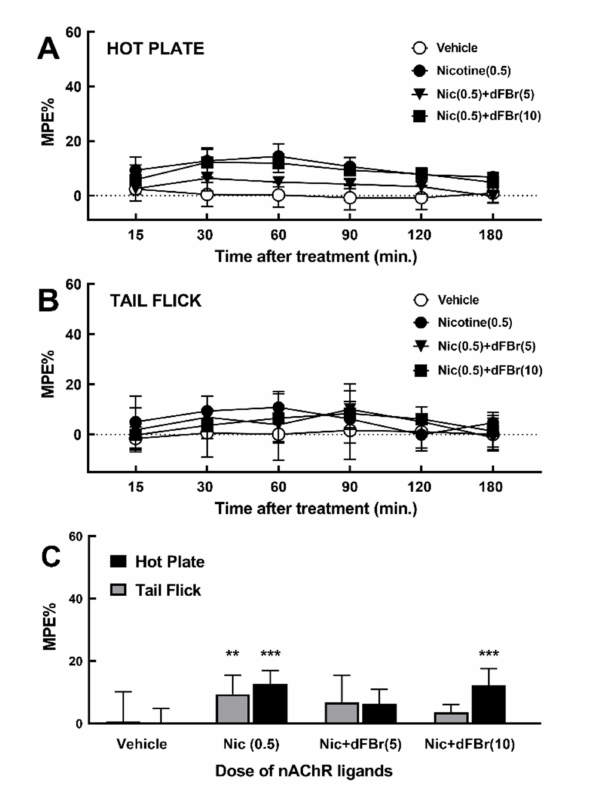
Figure 4. ( A and B ) Time course of the e ff ects of dFBr on nicotine-induced acute thermal antinociception in the hot plate and tail flick tests, respectively. Rats were pretreated with i.p. injection of vehicle or dFBr then with s.c. injection of 0.5 mg / kg nicotine, then subjected to the hot plate or tail flick at 15, 30, 60, 90, 120, and 180 min. Data are shown as mean %MPE ± SD of at least six rats per each treatment group, as detailed under Materials and Methods (Section 4.3.2). ( C ) Peak e ff ect at 30 min post-injection were analyzed using two-way ANOVA with Holm–Sidak’s multiple comparisons test. ** p < 0.01 and *** p < 0.001 indicate significant di ff erence between drug treatment versus vehicle group. dFBr treatments versus treatment with nicotine alone were not statistically significant ( p >